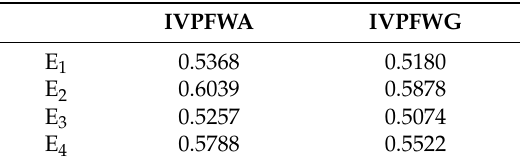
Table 7. The score functions of the suppliers.